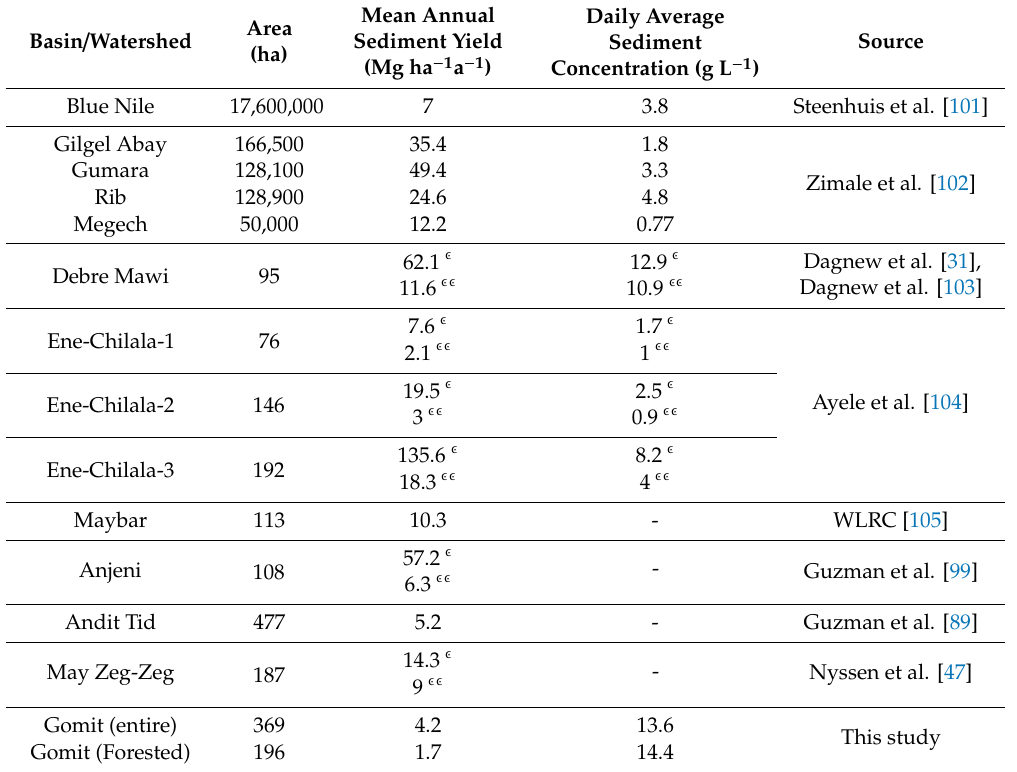
Table 5. Mean annual sediment yield and daily average sediment concentration in some Ethiopian watersheds.